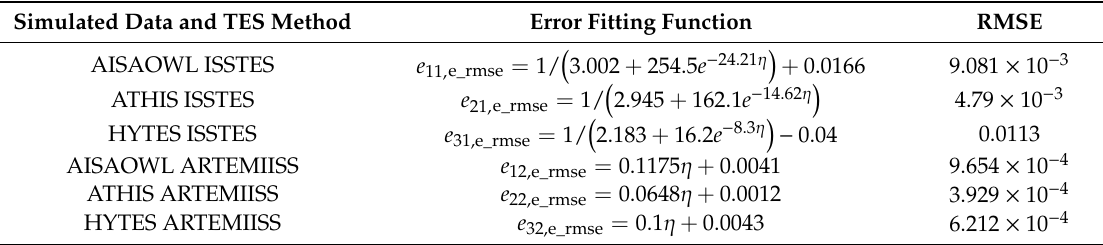
Table 14. The LSE error fitting function about NEDT when center wavelength shift ratio = − 0.05 and FWHM change ratio =